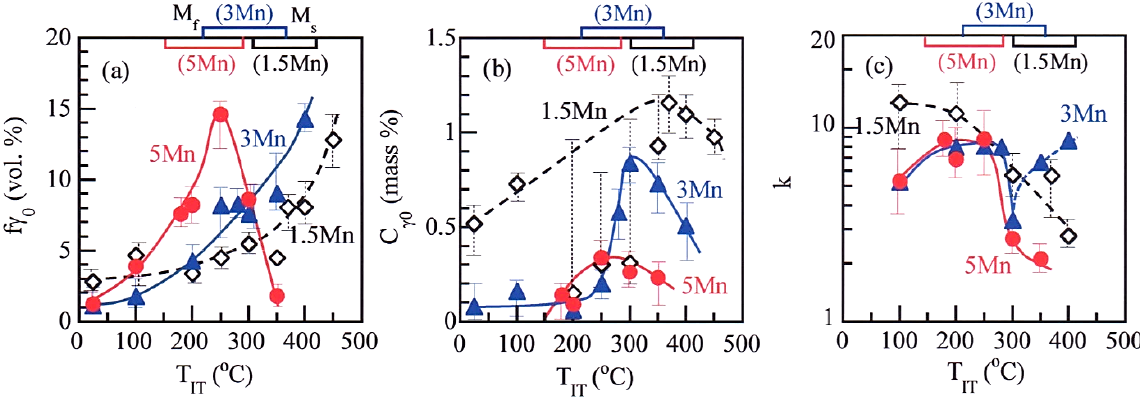
Figure 3. ( a – c ) Image-quality distribution maps of α -Fe (BCC) phase and ( d – f ) FE-SEM images of replicas in the 1.5Mn ( a , d ), 3Mn ( b , e ), and 5Mn ( c , f ) steels subjected to the IT process at T IT = 370 ◦ C, 280 ◦ C, and 180 ◦ C, respectively. The IT temperatures correspond to M f + (30 ◦ C to 70 ◦ C). PAGB, PB, and BB: prior austenitic grain, packet, and block boundaries, respectively. α m : coarse martensite, α m *: fine martensite, α bf : bainitic ferrite, γ R : retained austenite, θ : carbide, MA: mixed phase of α m * and γ R . f MA and f θ are volume fractions of the MA phase and carbide, respectively. RD and TD represent rolling and thickness directions, respectively.